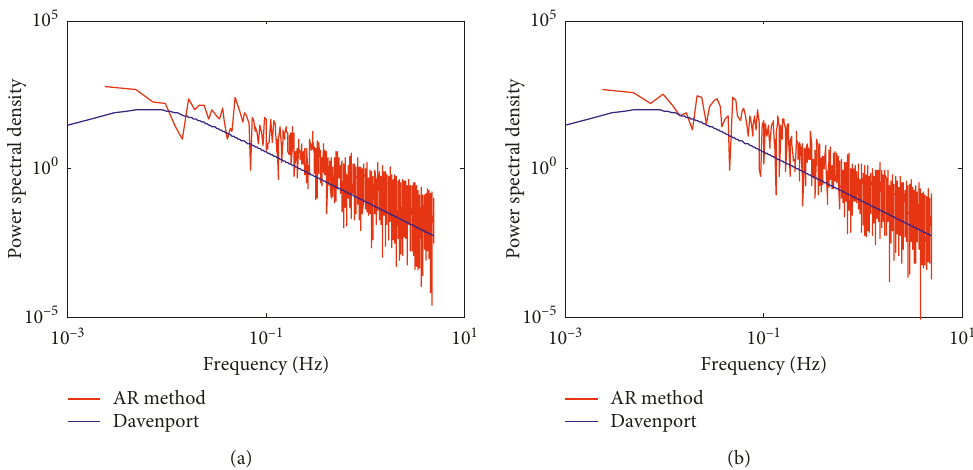
Figure 2: Comparison of the power spectral density between the simulated and Davenport spectral on the (a) fifth floor and (b) tenth floor. Table 1: Number of measurements and corresponding locations. Number of measurements Location (floor) 7 2, 3, 4, 5, 7, 9,